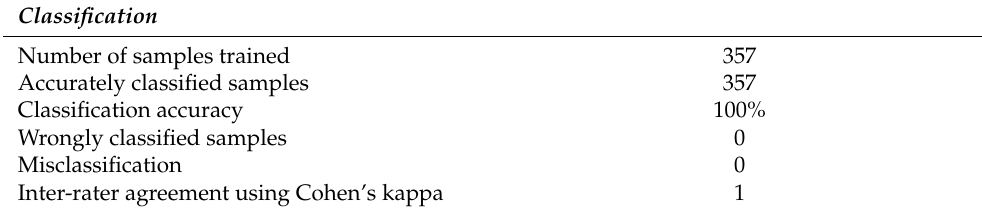
Table 3. Classification result for random